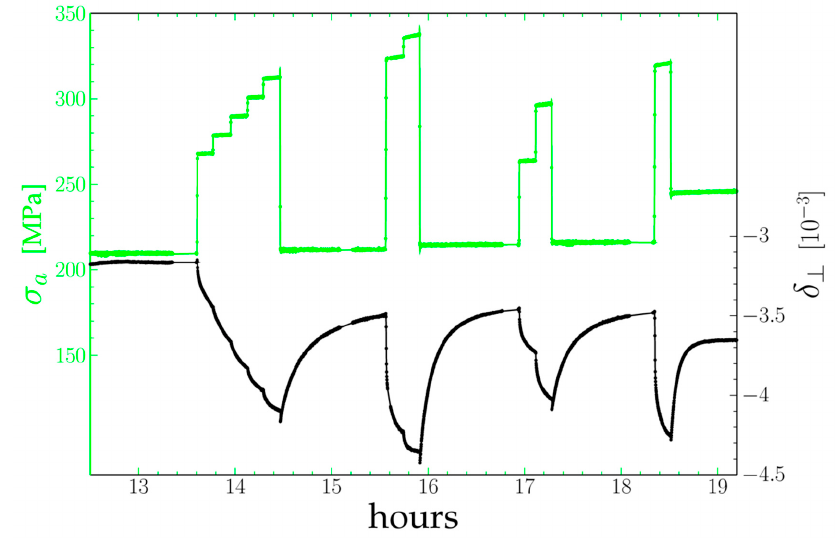
Figure 5. Evolution of the perpendicular misfit 𝛿 (cid:2884) (black) with the corrected applied stress 𝜎 (cid:3028) (green) of the “ small ” AM1 sample at 970 °C. Each dot corresponds to a seven seconds diffraction peak